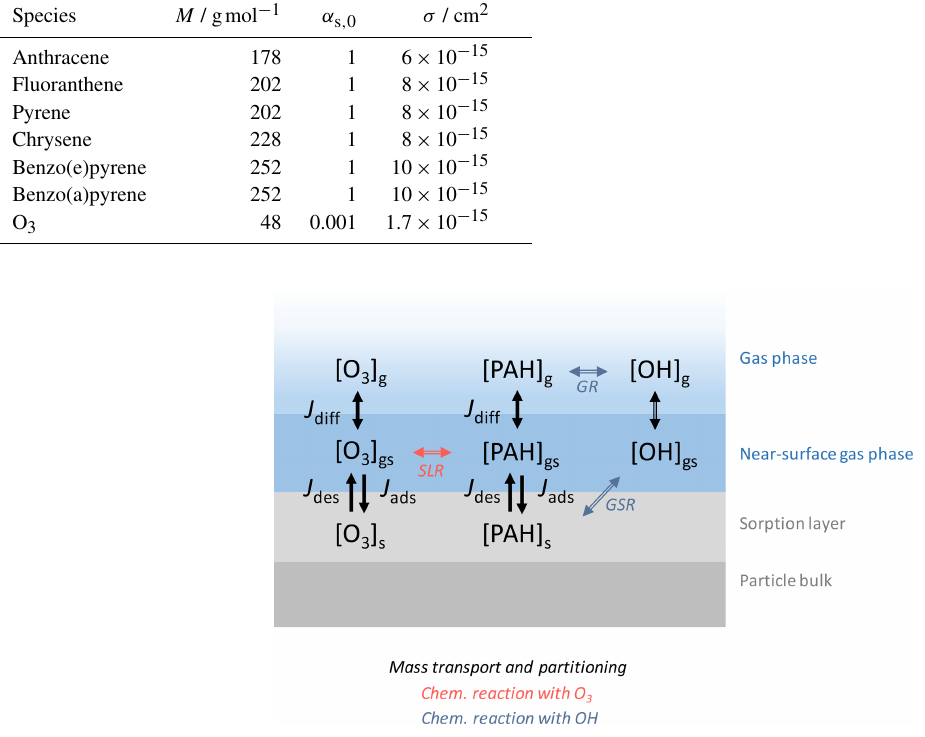
Figure A1. The model used in this study consists of three layers: gas phase, near-surface gas phase, and sorption layer. The surface-layer reaction (SLR) with O 3 and the gas-surface reactions (GSR) and gas-phase reactions (GR) with OH are modeled alongside mass transport and partitioning. J diff , J des , and J ads represent the gas diffusion flux between the gas phase and the near-surface gas phase, the desorption flux from the particle surface to the near-surface gas phase, and the adsorption flux from the near-surface gas phase to the particle surface, respectively. Note that, for the gas diffusion flux of OH, gas diffusion was implemented through a correction factor C g , OH .